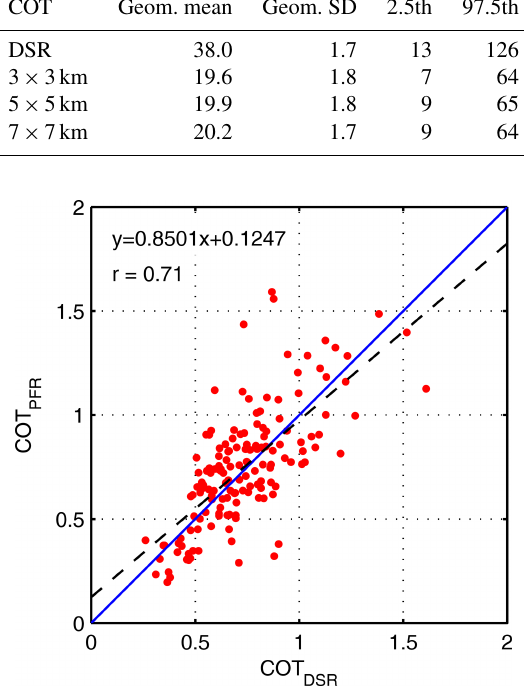
Figure 10. Correlation between COT values retrieved from DSR (COT DSR ) and COT values retrieved from PFR measurements at λ = 412nm (COT PFR ) for Ci–Cs in